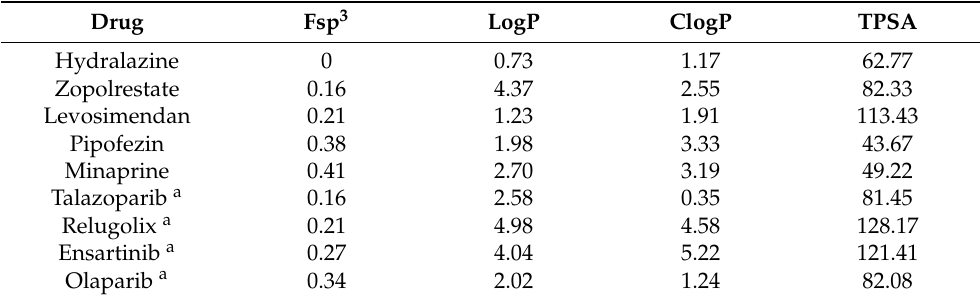
Table 2. The physicochemical parameters of drugs and drugs under development a .